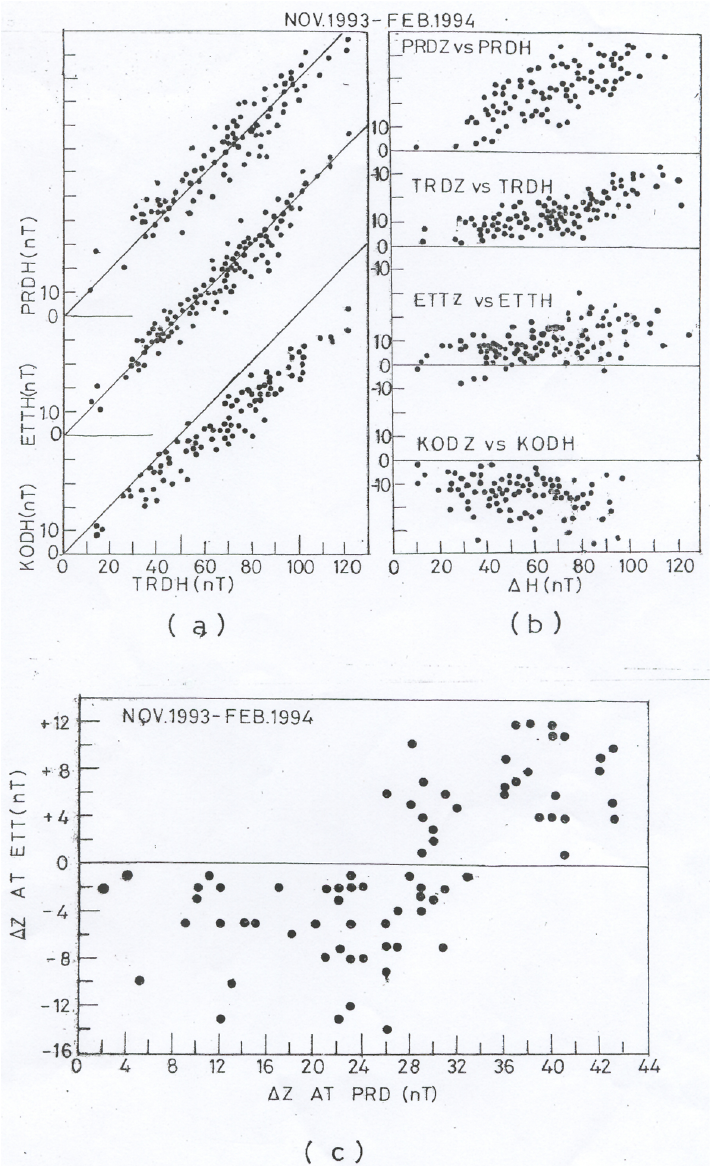
Fig. 8. (a) Mass plot of 1H on individual days at PRD, ETT and KOD versus corresponding 1H at TRD for the period November 1993– February 1994. (b) Mass plot of 1Z versus corresponding 1H at each of the stations PRD, ETT and KOD for the period November 1993–February 1994. (c) Mass plot of 1Z at ETT against 1Z at PRD during the period November 1993–February